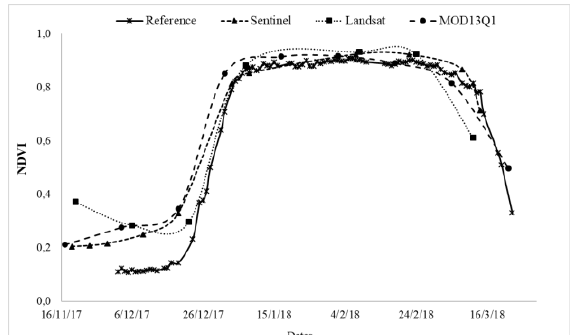
Figure 6. Normalized Difference Vegetation Index (NDVI) data for soybean crop obtained by functions of the reference data.